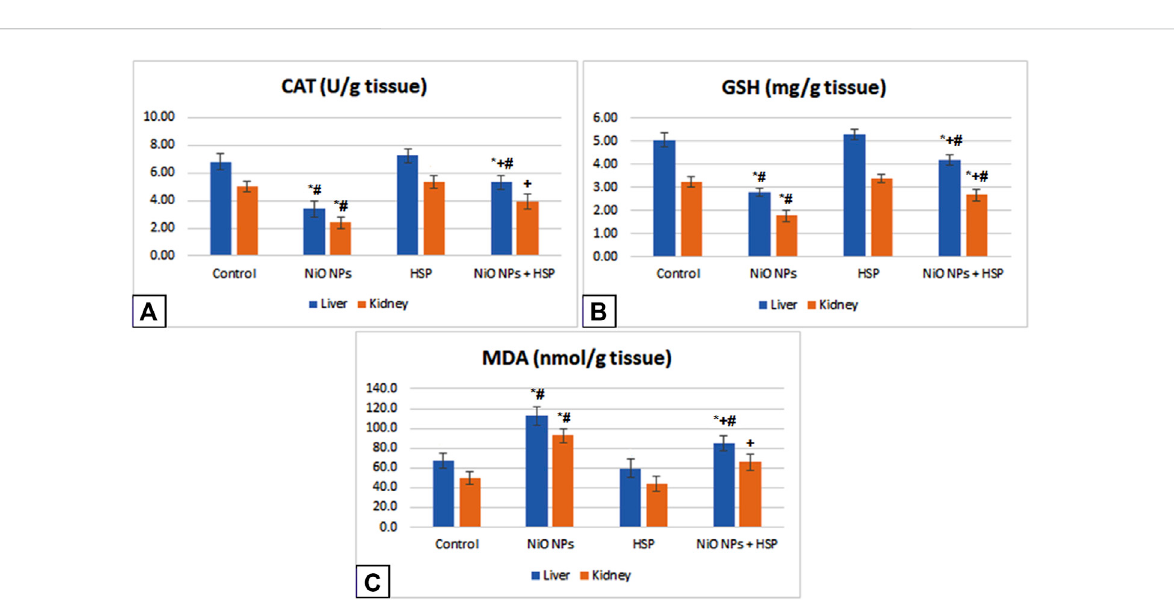
FIGURE 4 The effects of NiO-NPs and/or HSP exposure on oxidative stress and lipid peroxidation parameters, catalase (CAT, Fig. 4A), glutathione (GSH, Fig. 4B) and malondialdehyde (MDA, Fig. 4C), in the liver and kidney of rats. Values are presented as mean ± SD (n = 10 rats/group). * : Signi fi cantly different from Control group. + : Signi fi cantly different from NiO-NPs group. #: Signi fi cantly different from HSP group. Statistical signi fi cance level at p < 0.05